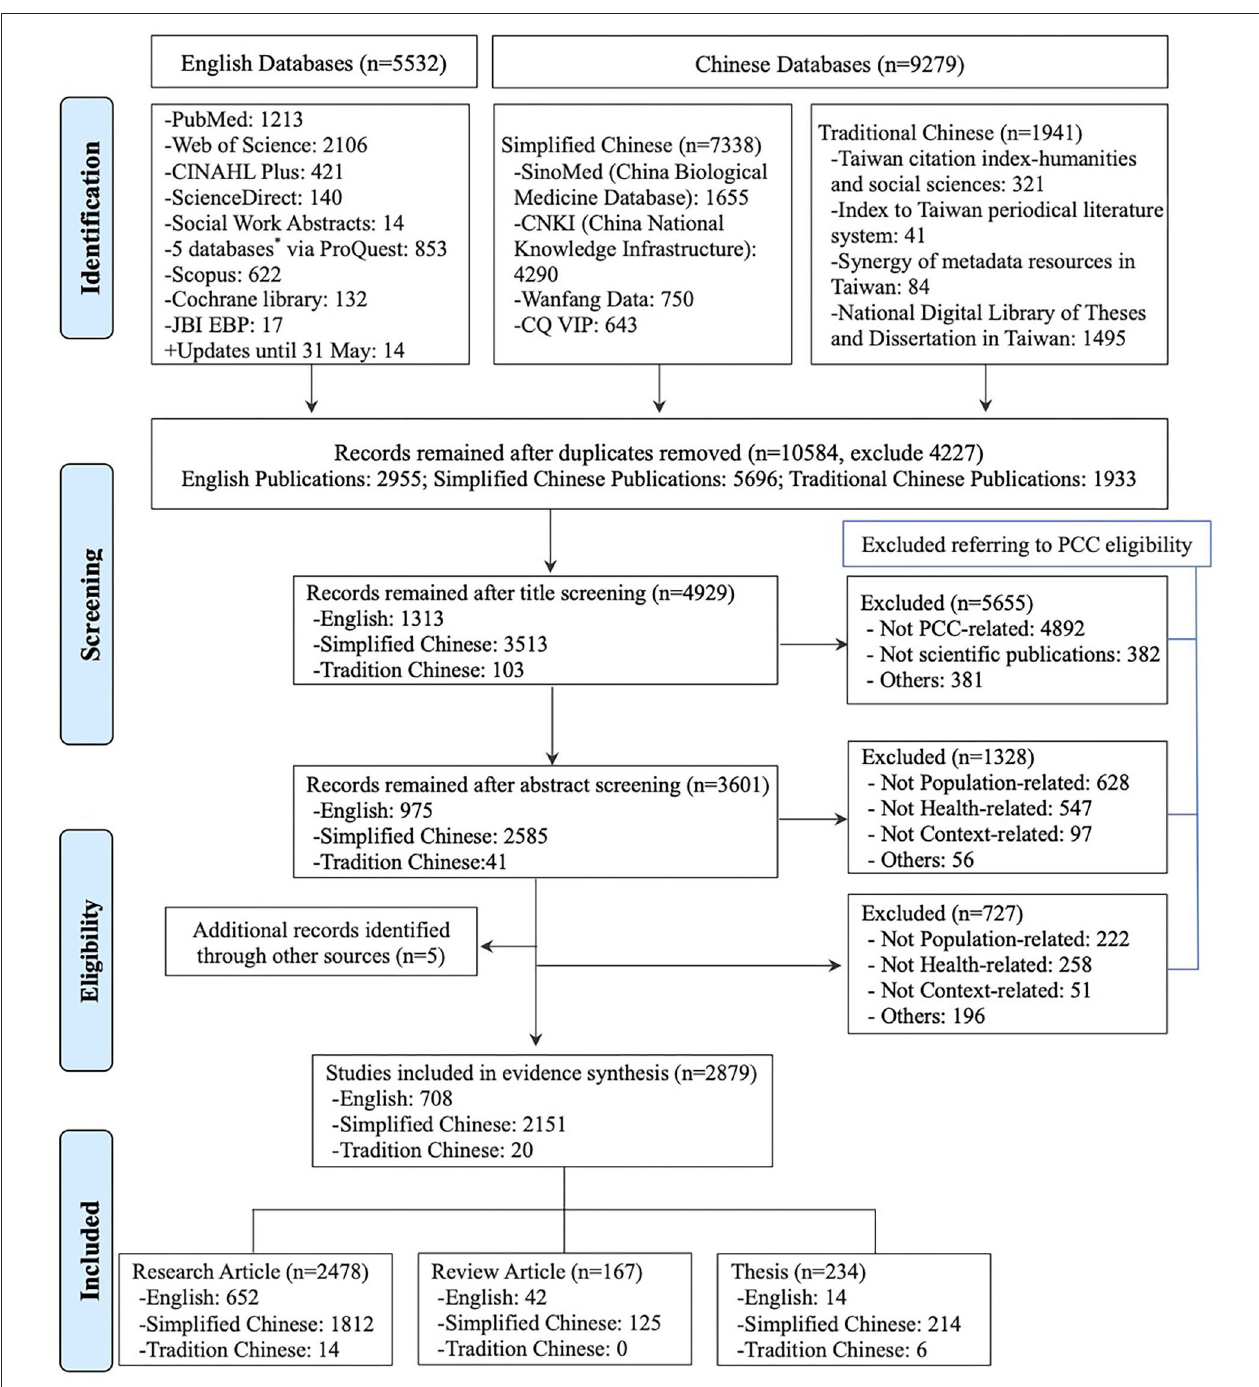
FIGURE 1 | Search results and study selection process referring to Preferred Reporting Items for Systematic Review and Meta-Analysis (PRISMA). *: ProQuest searching of the 5 databases: ProQuest Dissertations & Theses A&I; ProQuest Dissertations & Theses Global; APA PsycInfo; Sociological Abstracts; Social Services